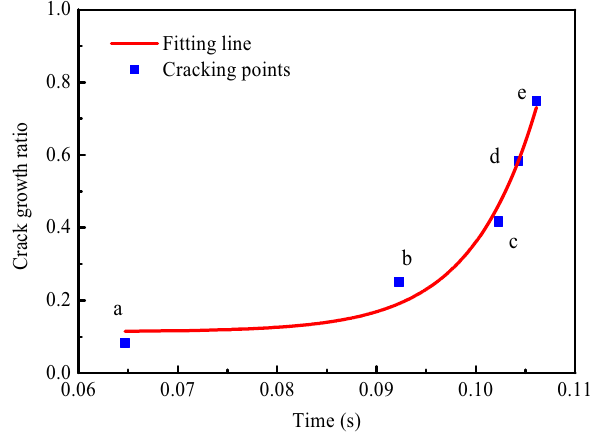
Figure 5: Crack growth